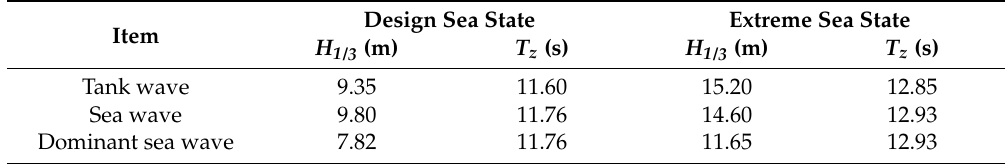
Table 5. Comparison of the wave parameters under different conditions. Design Sea Item